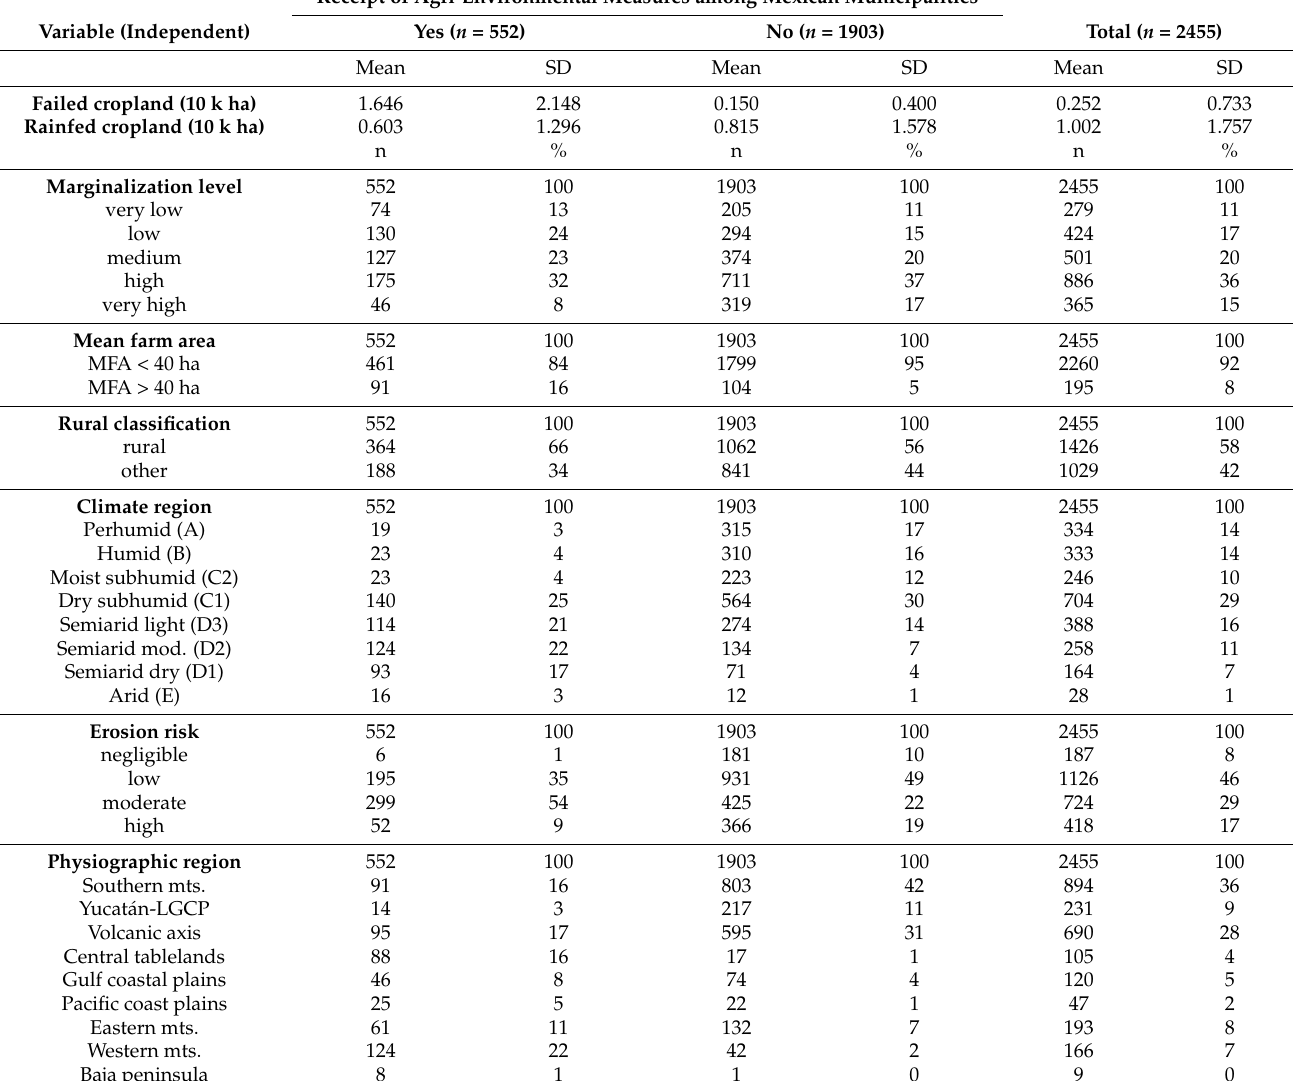
Table 1. Targeting indicators for municipalities with and without receiving support measures through Mexico’s PIASRE